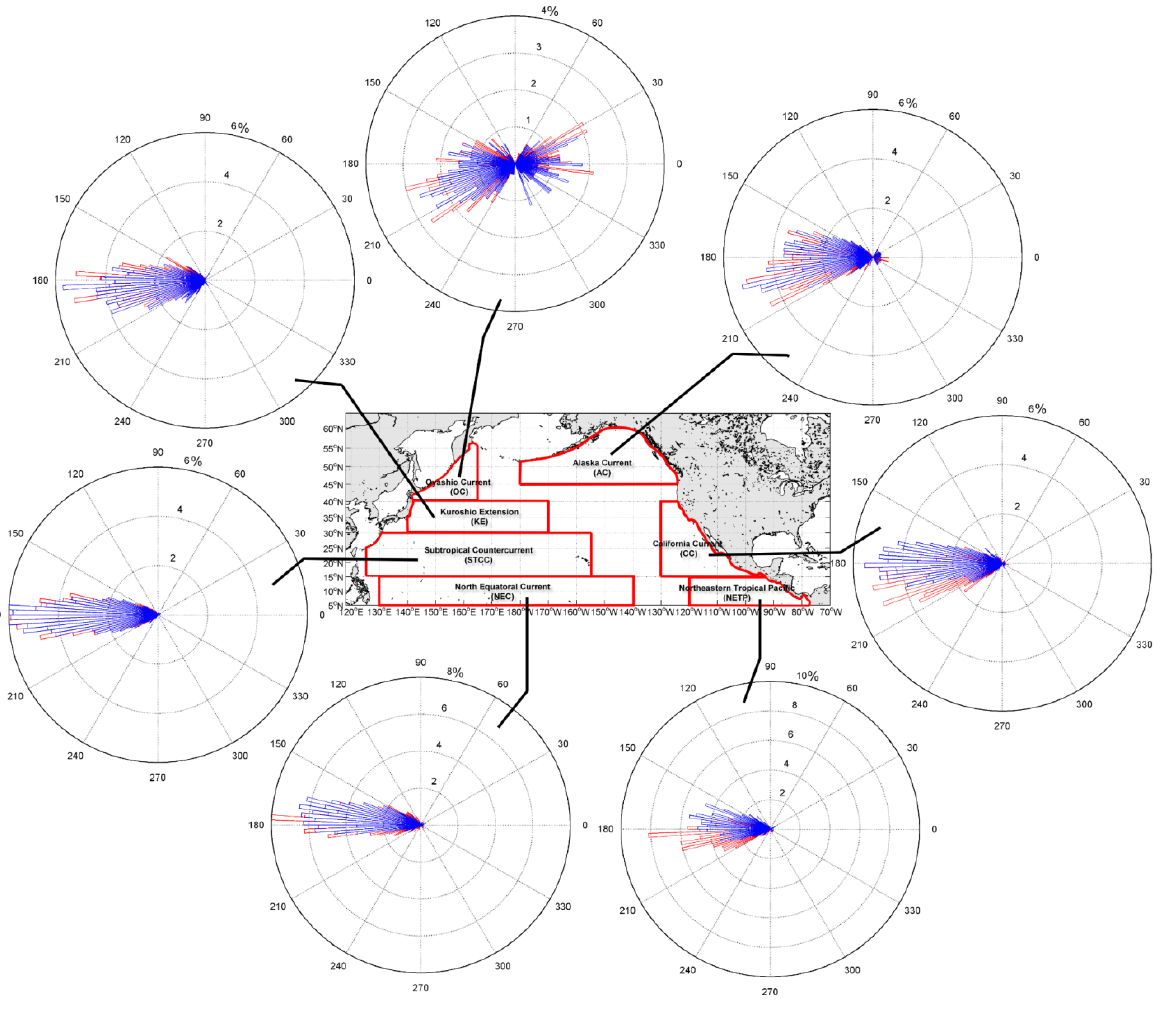
Figure 11. The propagation characteristics of cyclonic (blue) and anticyclonic eddies (red) with lifespans longer than or equal to 4 weeks. Circular histogram of the mean azimuth relative to the east in seven active regions in Figure